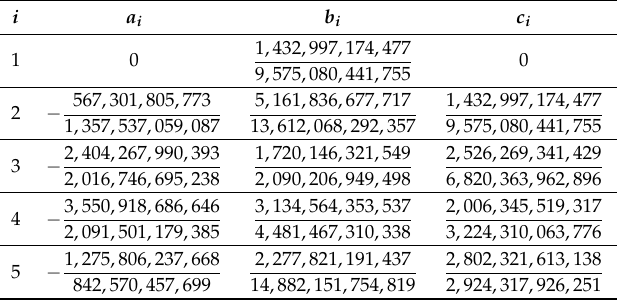
Table 1. Coefficients a i , b i and c i used for the low storage five-stage fourth-order explicit Runge–Kutta